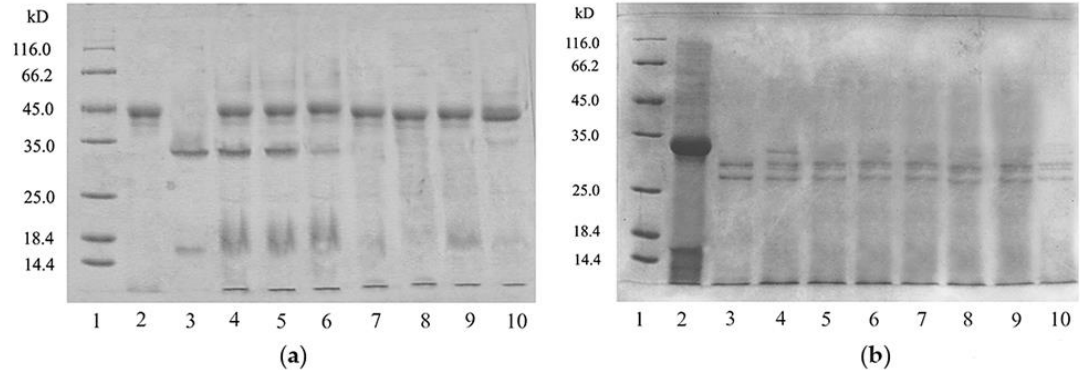
Figure 11. ( a ) SGF digestion profiles of the preheated lectin from the Zihua snap bean. In the SDS-PAGE analysis, lane 1 was the molecular weight marker, lane 2 was the pepsine, lane 3 was the native lectin, and lanes 4 to 10 were the SGF digestion pattern of the native lectin at 0 min, 2 min, 5 min, 10 min, 20 min, 30 min, and 60 min. ( b ) SIF digestion profiles of the preheated lectin from the Zihua snap bean. In the SDS-PAGE analysis, lane 1 was the molecular weight marker, lane 2 was the tryptic, lane 3 was the native lectin, and lanes 4 to 10 were the tryptic digestion pattern of the native lectin at 0 min, 10 min, 20 min, 30 min, 40 min, 60 min, and 90 min.